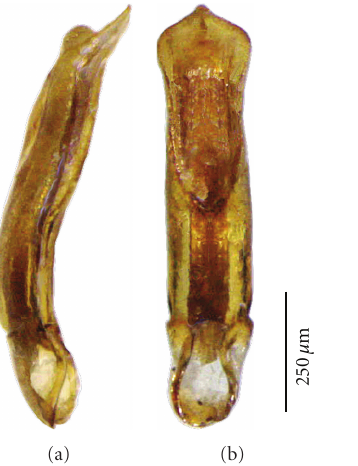
Figure 2: Neocrepidodera ferruginea , male aedeagus: (a) lateral view; (b) ventral view.